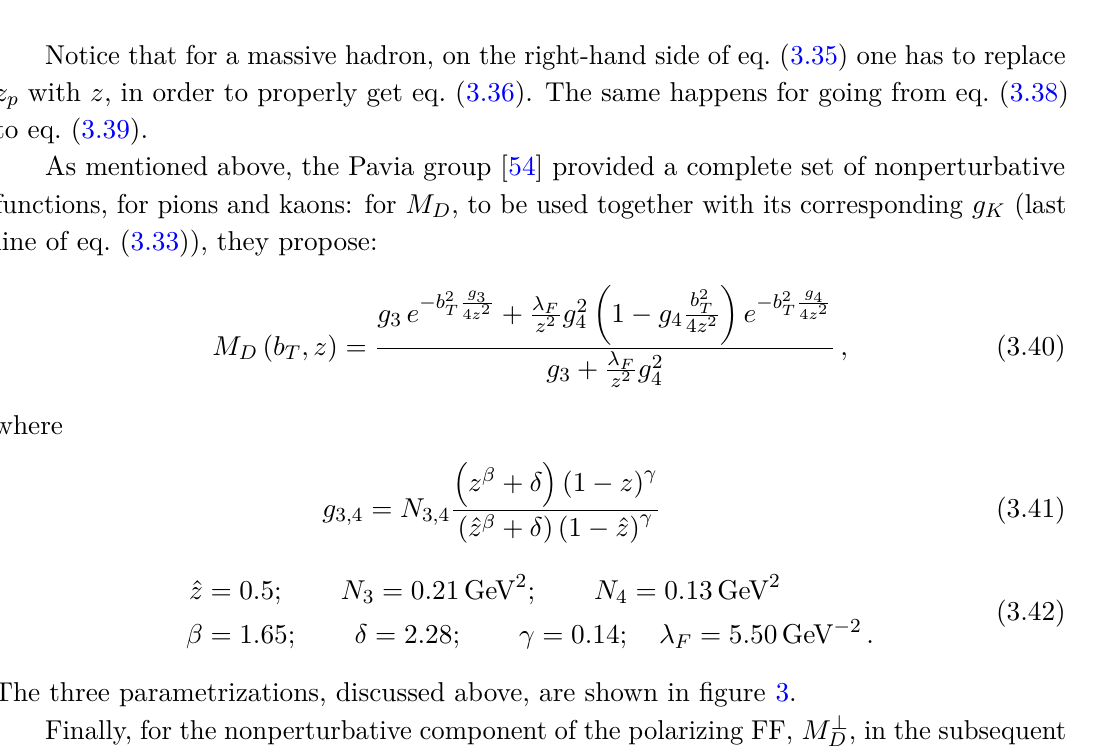
Figure 3 . Representation of nonperturbative hadronic models for M D ( b T , z ) as a function of b T at different values of z : Gaussian (orange solid line), Power-Law (blue dot-dashed line) and PV17 (green dotted line)